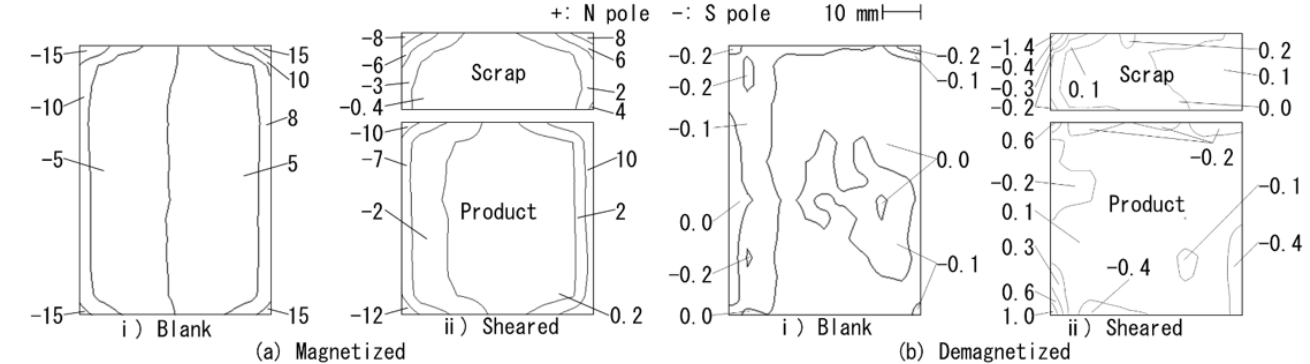
Figure 7. Magnetic flux density distributions of 1180 MPa steel sheet: ( a ) before shearing and ( b ) after shearing.